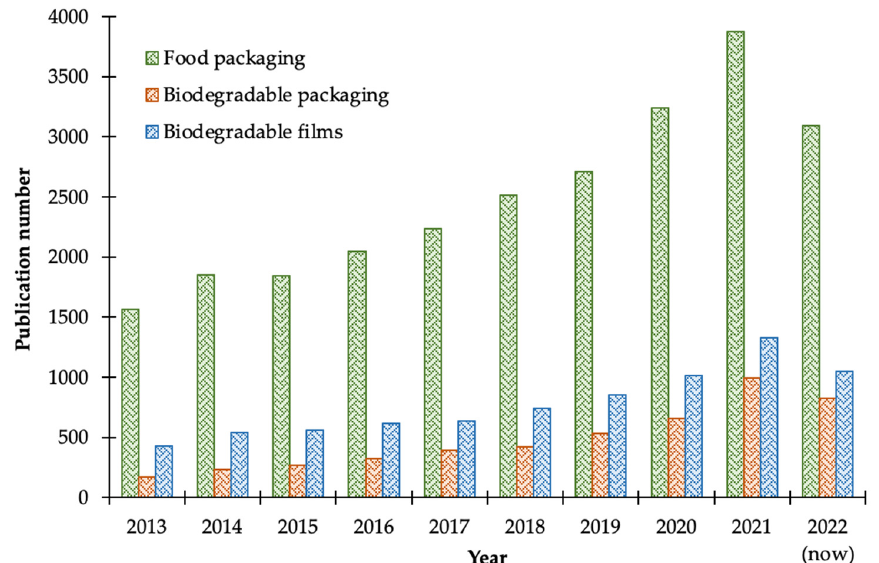
Figure 1. The number of publications related to food packaging and biodegradable films (Source: Scopus. Keywords: food packaging, biodegradable packaging, and biodegradable films. Accessed: 27 September 2022).